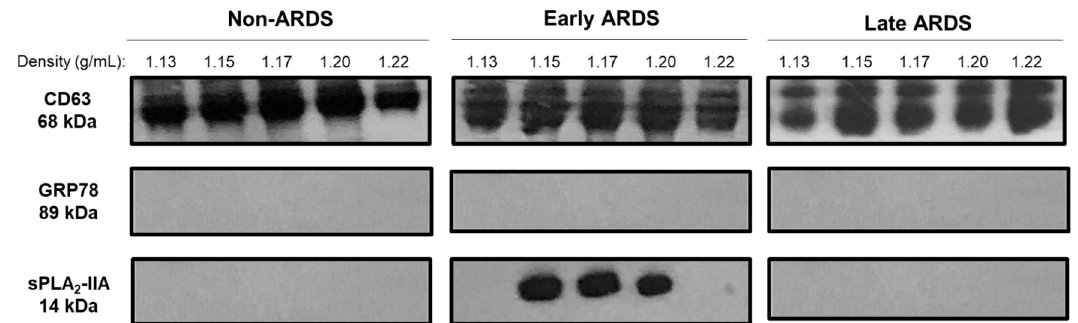
Figure 2. Immunoblotting analysis of CD-63, Grp-78 and sPLA 2 -IIA in BAL fluid density fractions from representative control, early and late ARDS samples. The pictures are representative of 9 early, 5 late ARDS and 7 non-ARDS crude small EVs isolations, fractionated on sucrose density gradient.